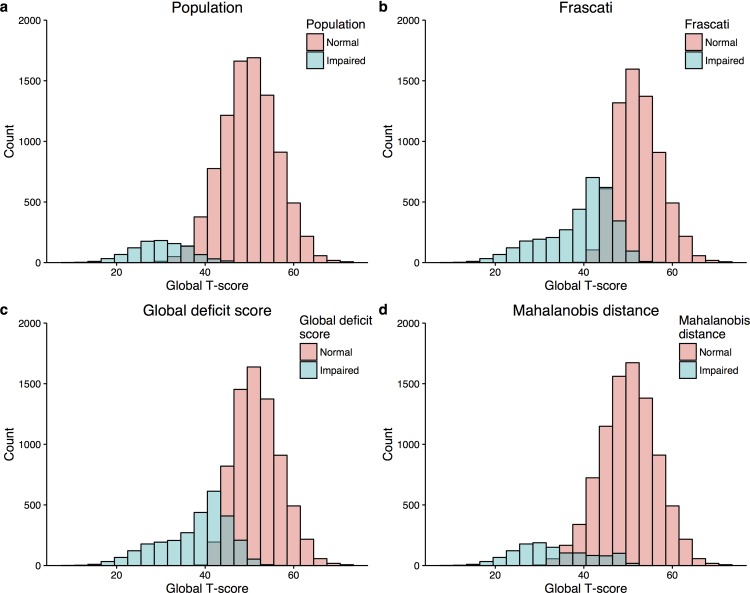
Histograms of a simulated study population with a 10% prevalence of cognitive impairment.Panel a) 90% of the population are ‘normal’ and have a mean (standard deviation) T-score of 50 (10)–red. 10% of the population are impaired and have a mean T-score of 30 (10). Panels b-d: how the population is labelled by method used to define impairment.